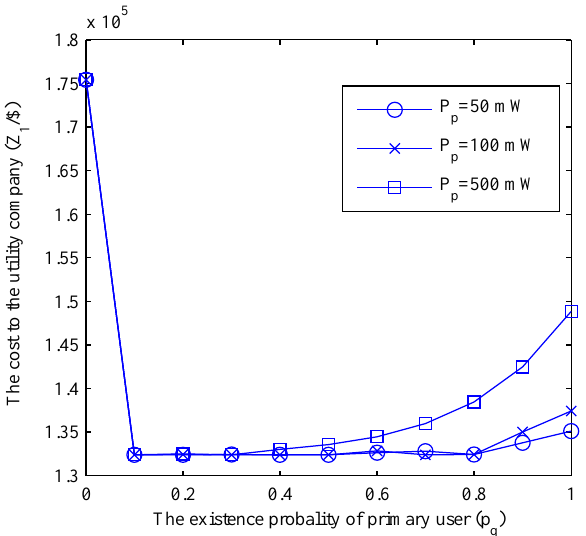
Figure 9. The cost to utility company under different P p